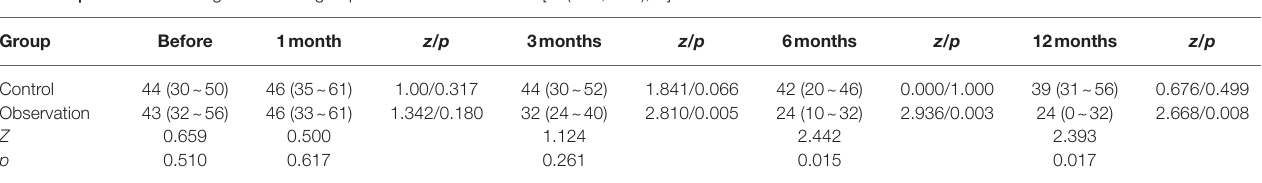
TABLE 7 | The insulin dosage in the two groups before and after ABMI [ M (P25, P75), U]. Group Before 1 month z/p 3 months z/p